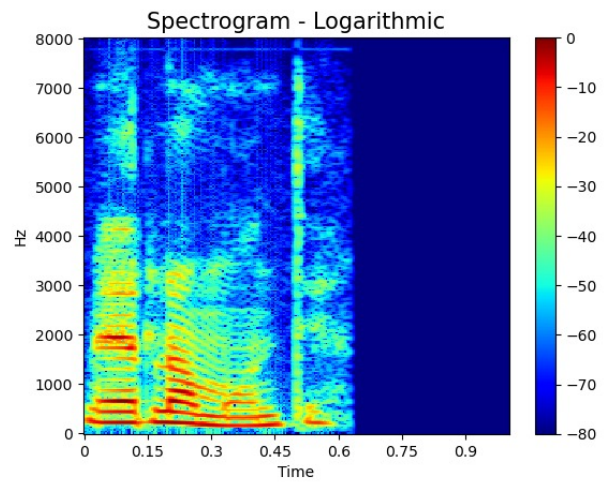
Figure 8. Sample spectrogram used as input to the neural